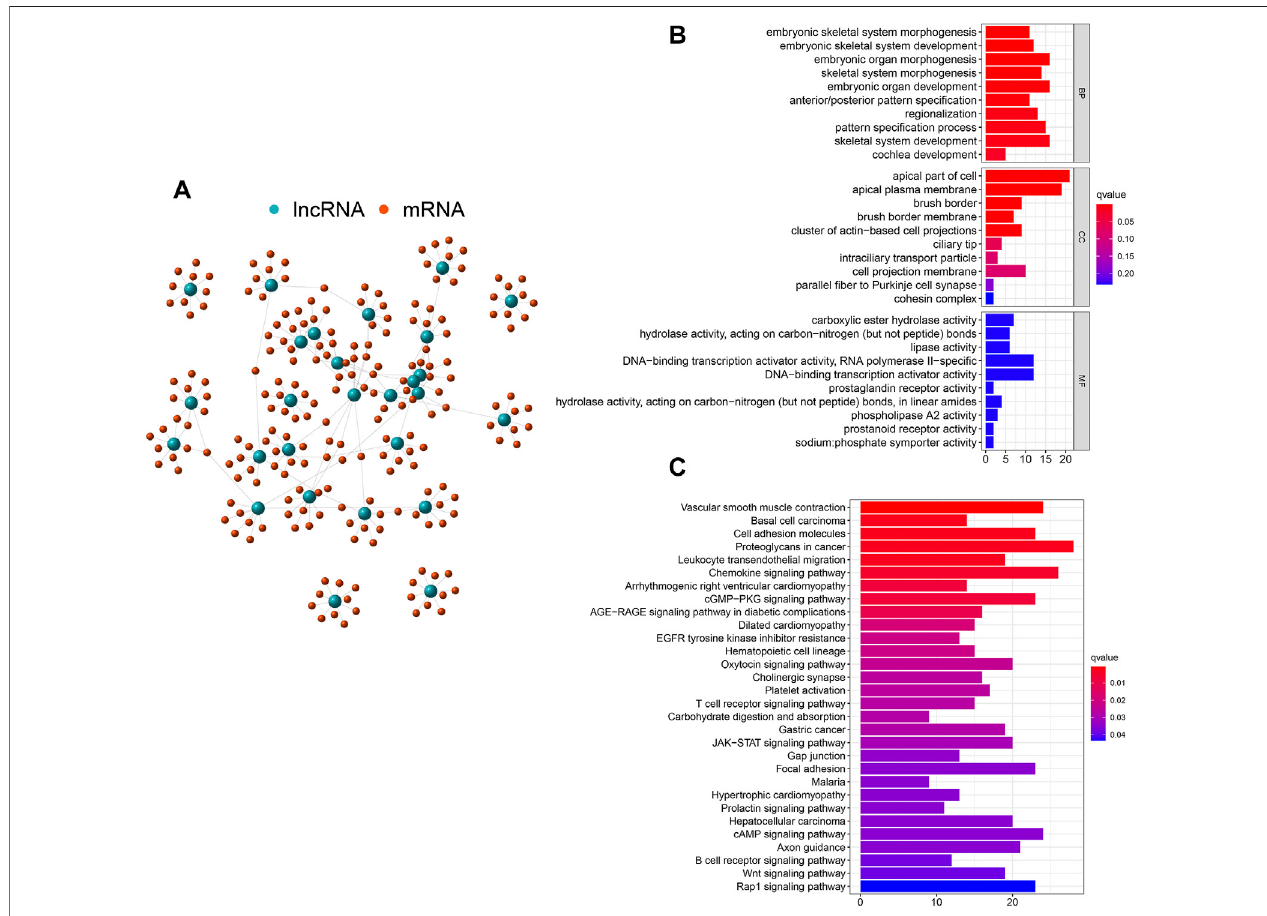
FIGURE 2 | Functional annotations of genomic instability-related lncRNAS in patients with KIRP. (A) .Co-expression network of mRNAs and lncRNAs associated with genomic instability. Gene Ontology (B) and Kyoto Encyclopedia of Genes and Genomes enrichment analysis (C) of the lncRNA co-expressed mRNAs.